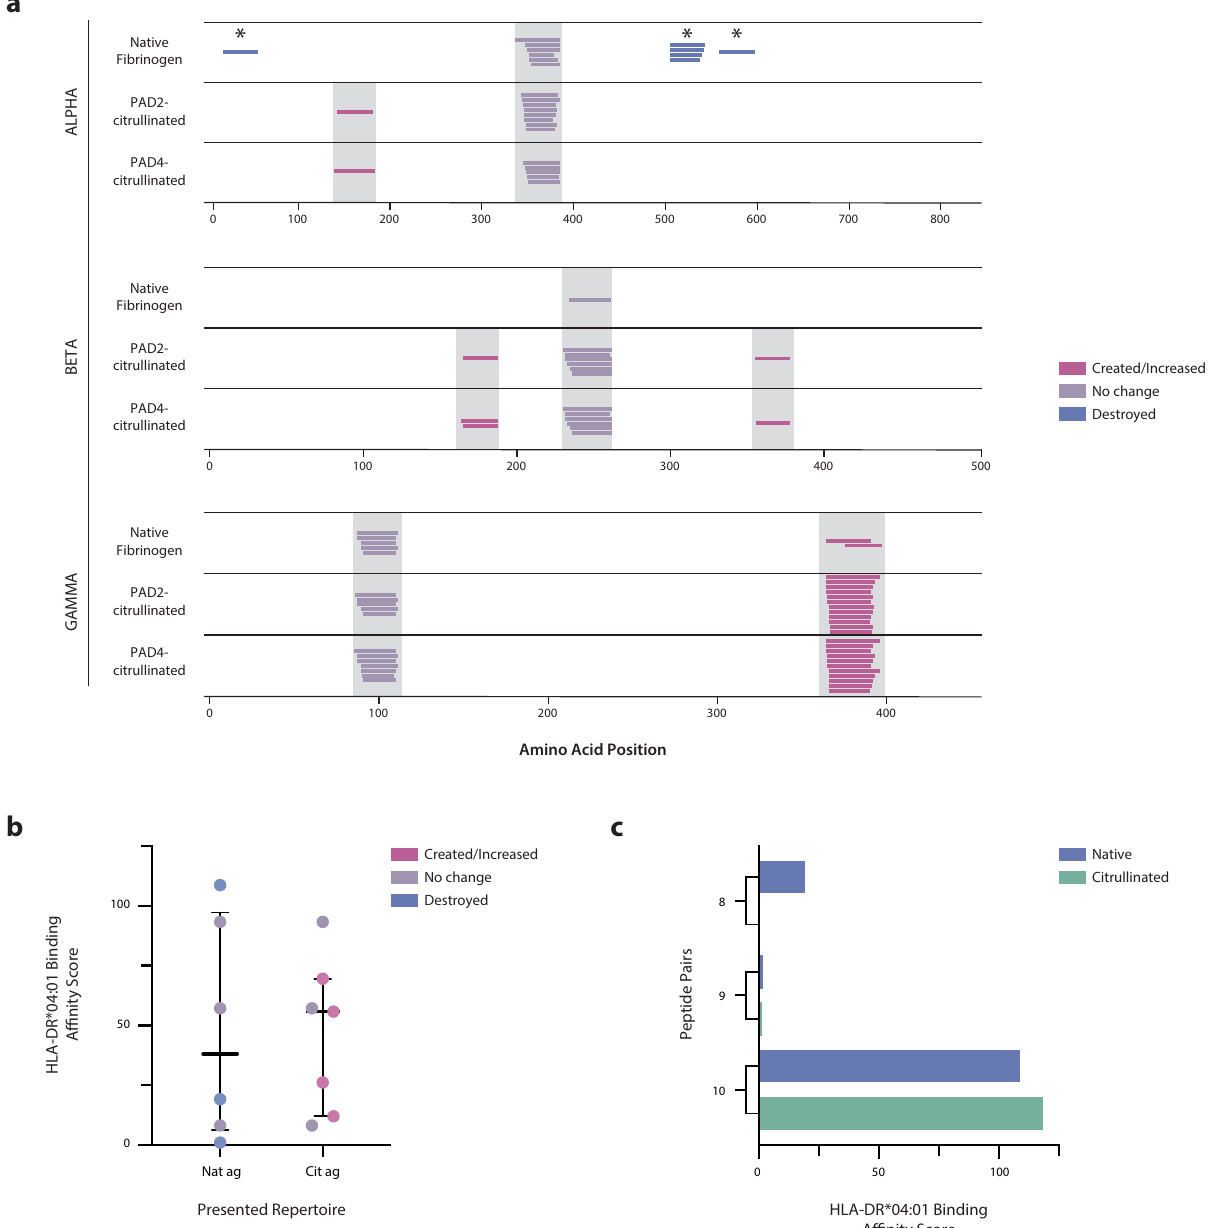
native antigen (Nat ag; n =6 peptides) and the citrullinated antigen (Cit ag; n =7 peptides) were measured by the ProImmune REVEAL® assay, which represents a surrogate for binding af fi nity through the quanti fi cation of MHC stabilization relative to an internal positive control peptide. The center lines represent the median, and the error bars denote the interquartile range. c HLA-DRB1*04:01 relative binding af fi nity scores as measured by the ProImmune REVEAL® assay for the three native and citrullinated peptide